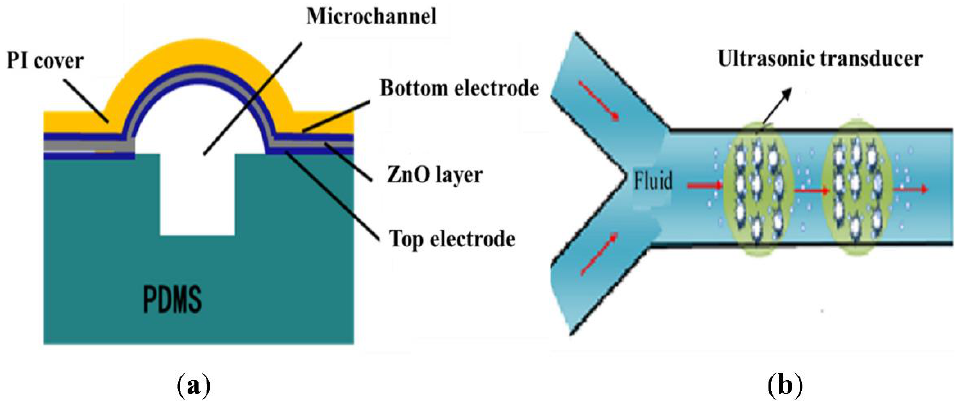
Figure 2. Schematic diagram of the microfluidic ultrasound gene transfer system MEMS ( a ) self- focusing ultrasonic transducer; ( b ) microchannel.